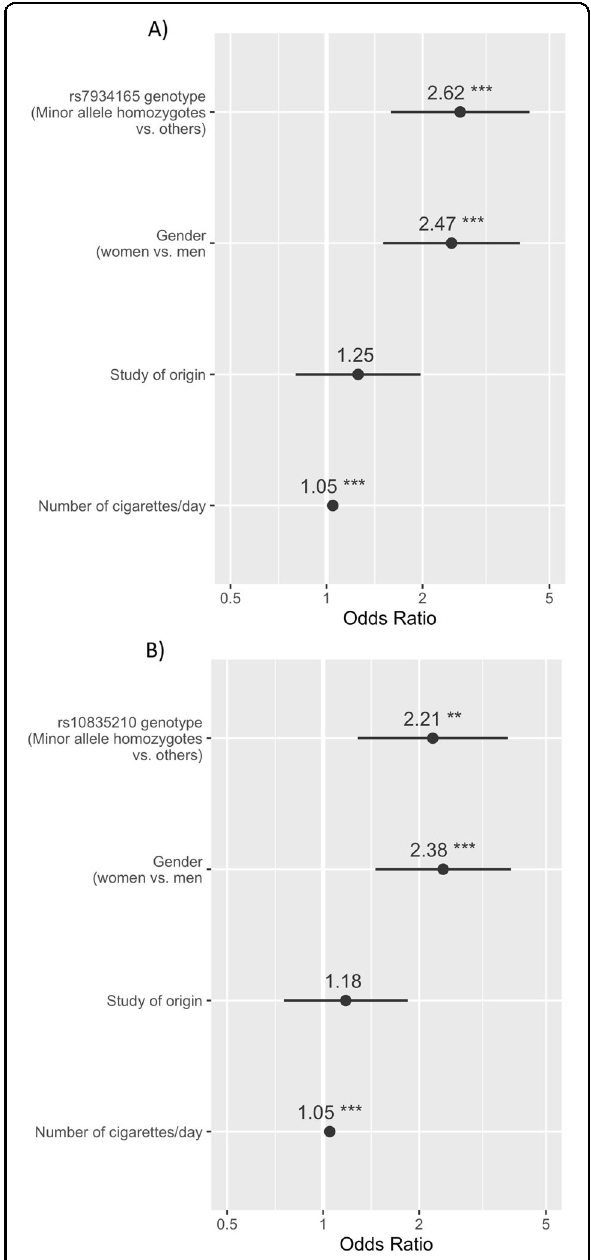
Fig. 2 Plots for logistic regression with ‘ any ’ SA as a dependent variable, sociodemographic and clinical confounders and (A) rs7934165 or (B) rs10835210BDNF polymorphisms as independent variables. Odds ratios are displayed. Bars indicate 95% con fi dence intervals. * p < 0.05, ** p < 0.01, and *** p <